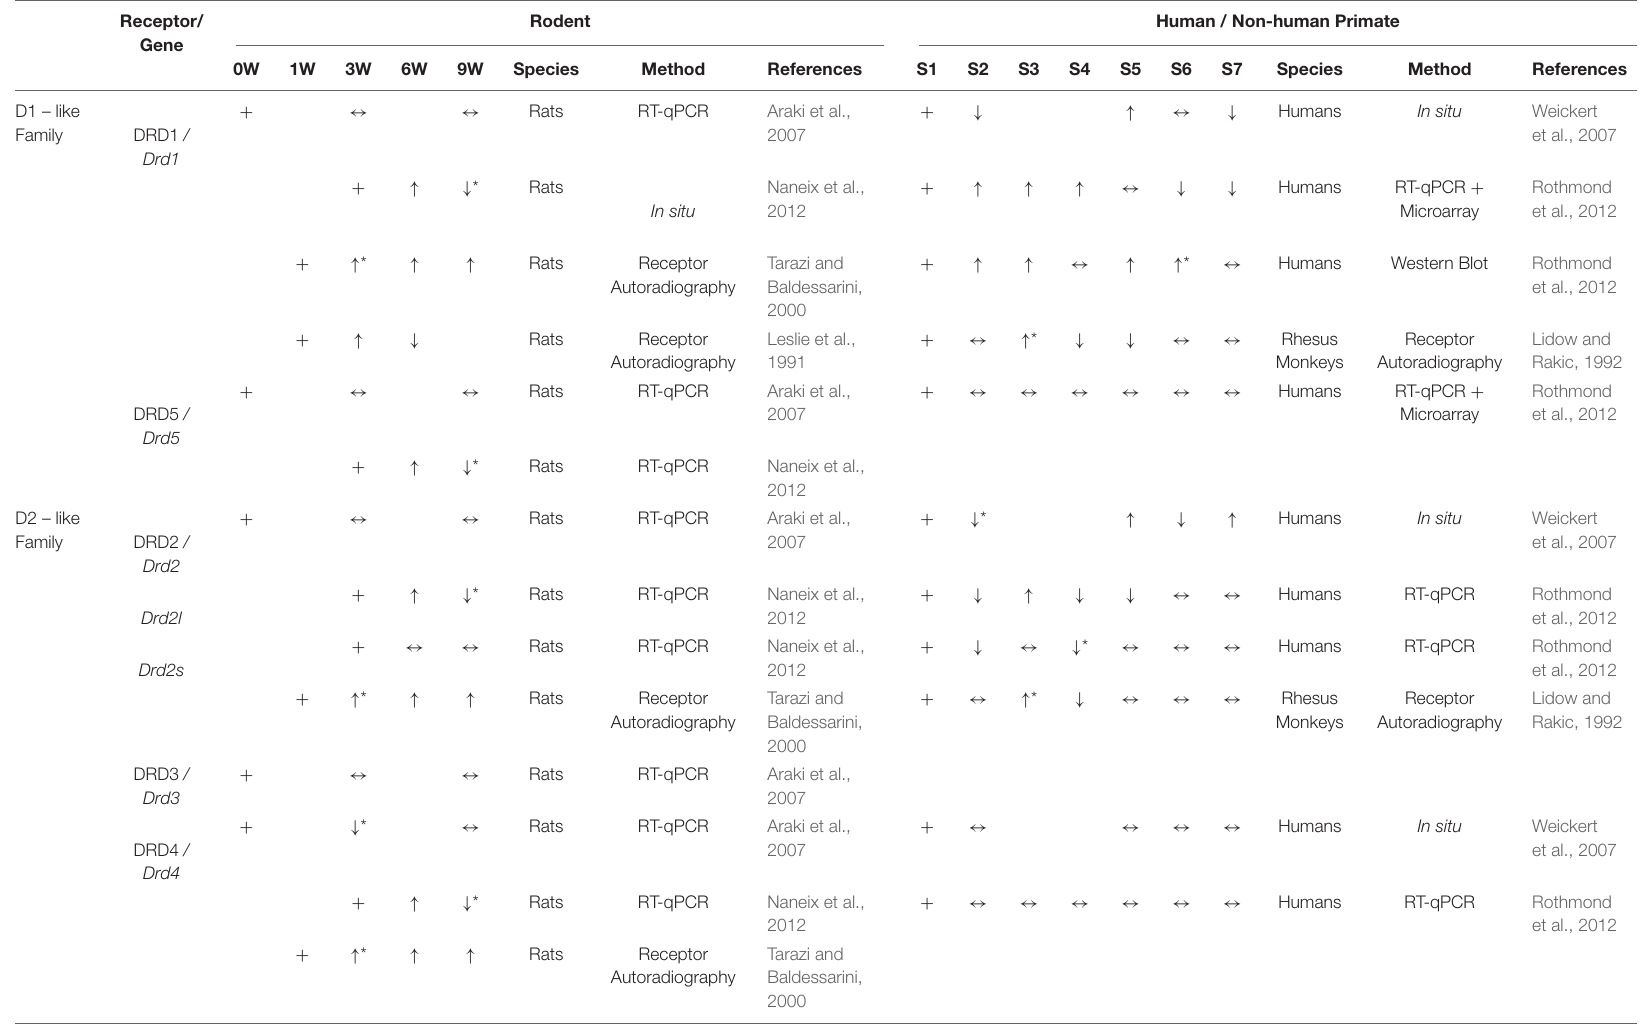
TABLE 2 | Relative changes in expression of Drds /DRDs in PFC throughout postnatal